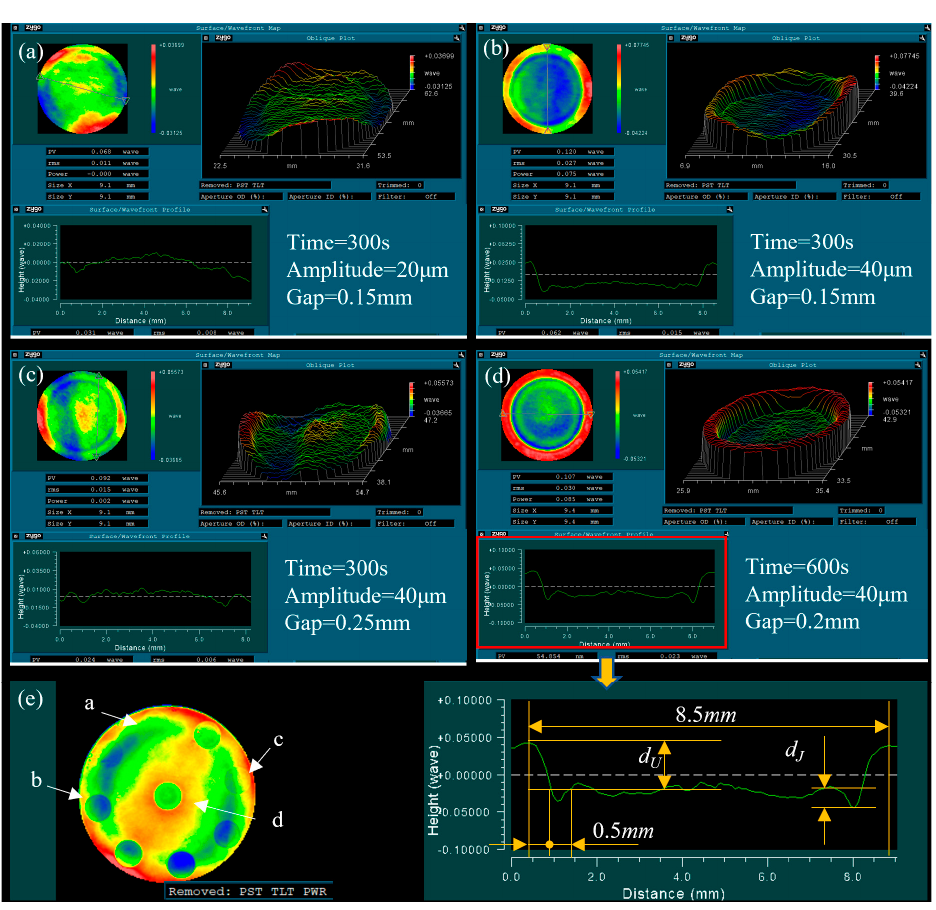
Figure 7. Removal pit profiles after using the ultrasonic tool: ( a ) removal pit under the processing parameters of time = 300 s, amplitude = 20 μ m, and gap = 0.15 mm; ( b ) removal pit under the processing parameters of time = 300 s, amplitude = 40 μ m, and gap = 0.15 mm; ( c ) removal pit under the processing parameters of time = 300 s, amplitude = 40 μ m, and gap = 0.25 mm; ( d ) removal pit under the processing parameters of time = 60 s, amplitude = 4 μ m, and gap = 0.2 mm; and ( e ) the lens’s overall surface shape error distribution after the experimental processing.